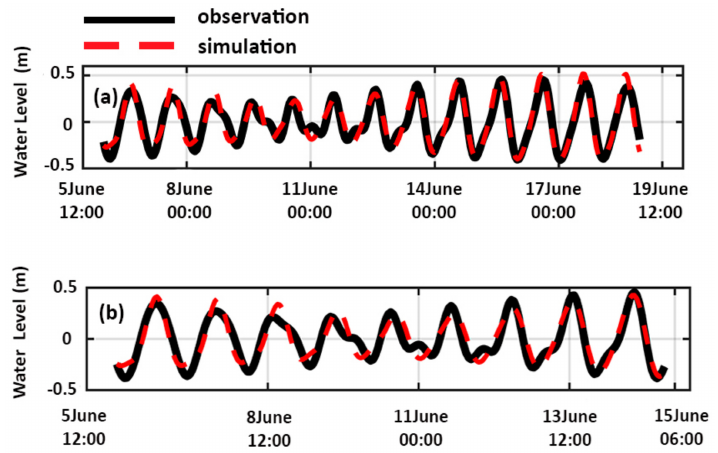
Figure 4. Comparisons of tidal level between the model results and the field data at ( a ) Kolinamil Station and ( b ) Kayangan Station.